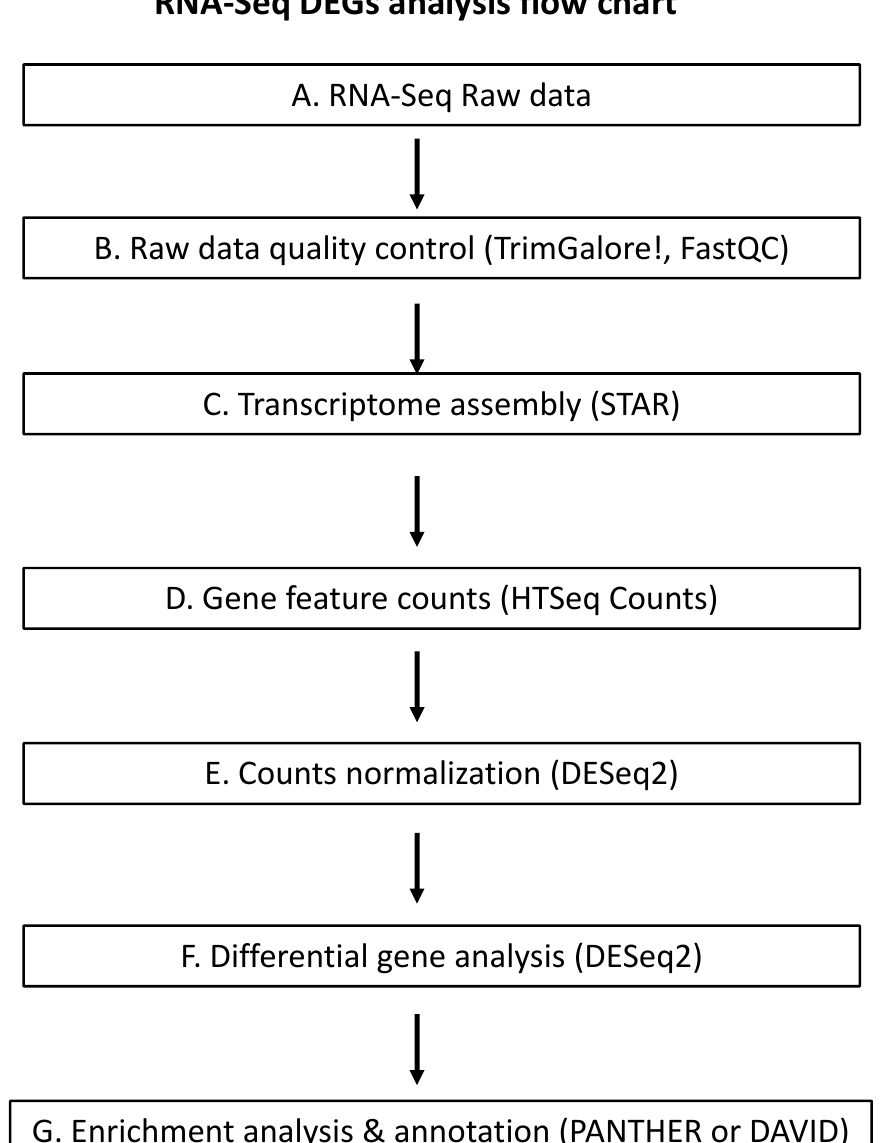
Figure 3. Typical pipeline for RNA-Seq data analysis for differential gene expression analysis with known reference genome consists of five steps, raw data quality control, transcriptome assembly, gene feature counts, counts normalization, differential gene analysis, functional annotation. Example of bioinformatics tools for each step is listed in